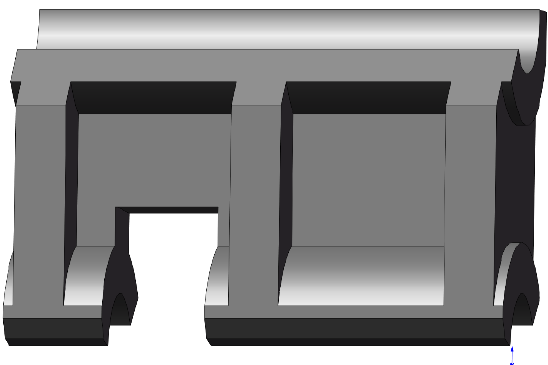
Figure 12. The lightweight drive rod based on fully symmetry structure.